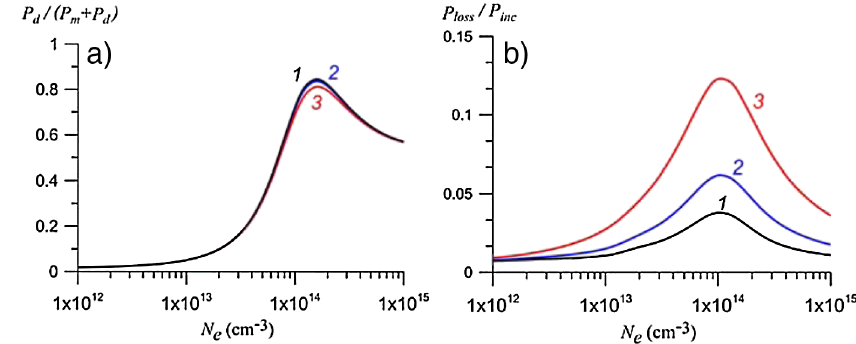
FIG. 5. (Color) (a) Coefficient of reflections from the grating into the diffraction beam as a function of electron density. (b) Share of the microwave power absorbed in the plasma as a function of electron density for different gas pressures. Gas pressure in the grating grooves is 0.3 Torr (1), 1 Torr (2), and 3 Torr (3). Here, P power absorbed in the plasma, and P inc ¼ P